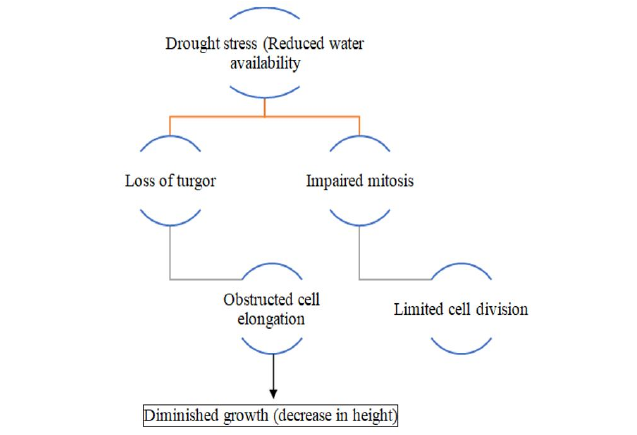
Figure 1: Drought effect on growth of